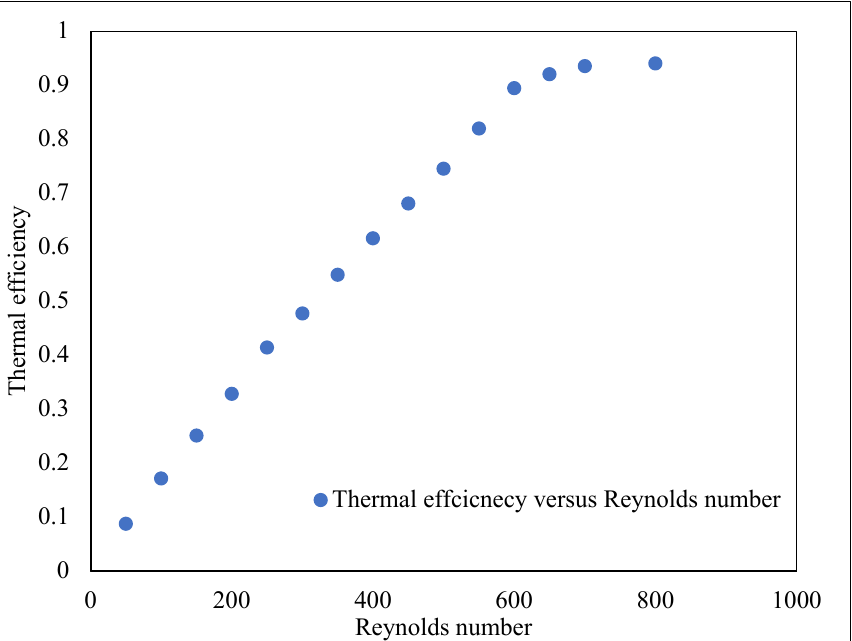
Figure 9. Graphical representation of thermal efficiency versus Reynolds number at inlet.